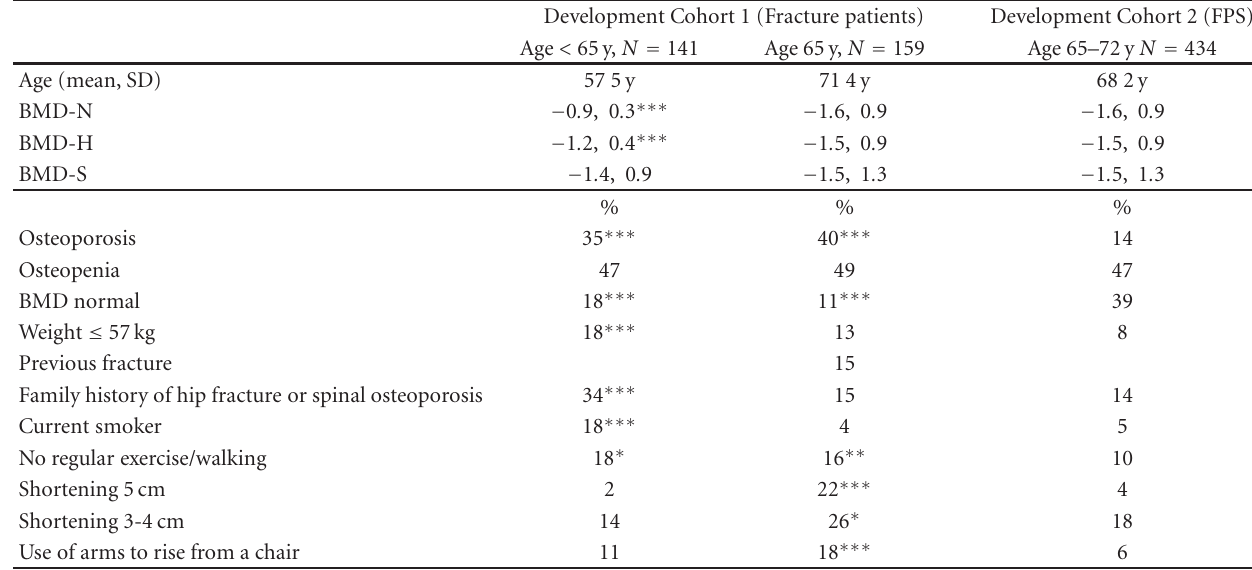
Table 1: BMD and prevalence of risk factors (%) in the development patient cohorts.